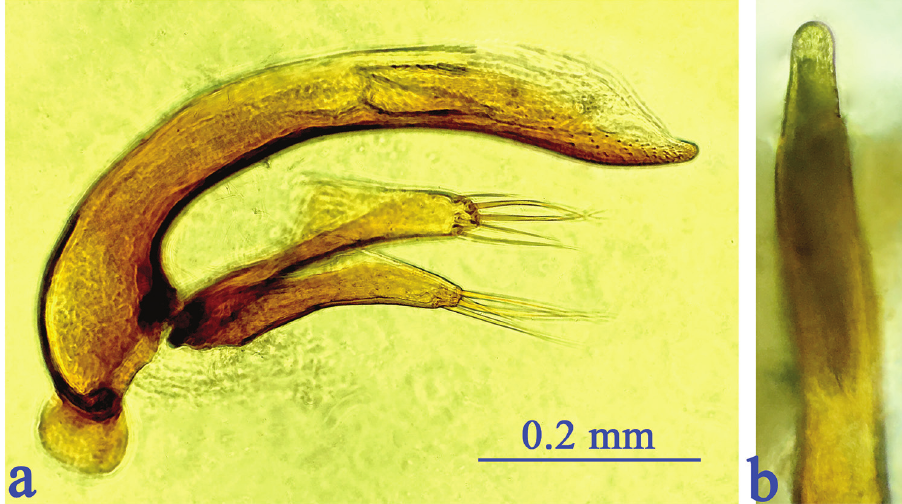
Figure 5. Male genitalia of Shuangheaphaenops elegans gen. n., sp. n. a median lobe and parameres, lateral view b apical lobe, dorsal